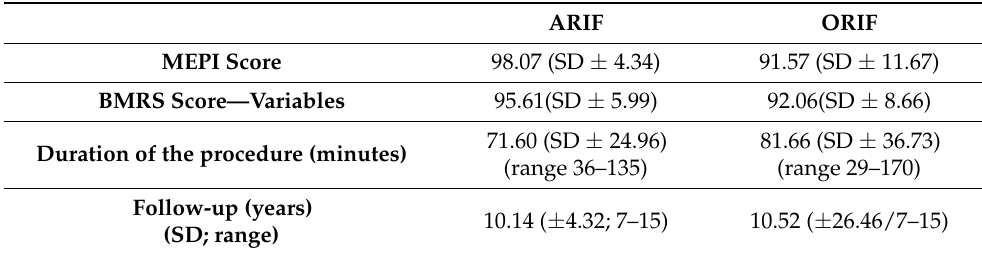
Table 3. Clinical and functional results of ARIF and ORIF.